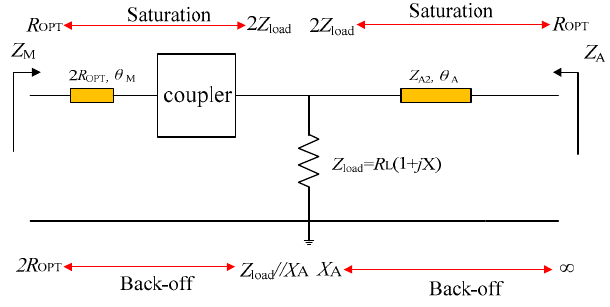
Figure 9. Impedance transformation of the proposed DPA. Table 2. The values of the corresponding parameters.